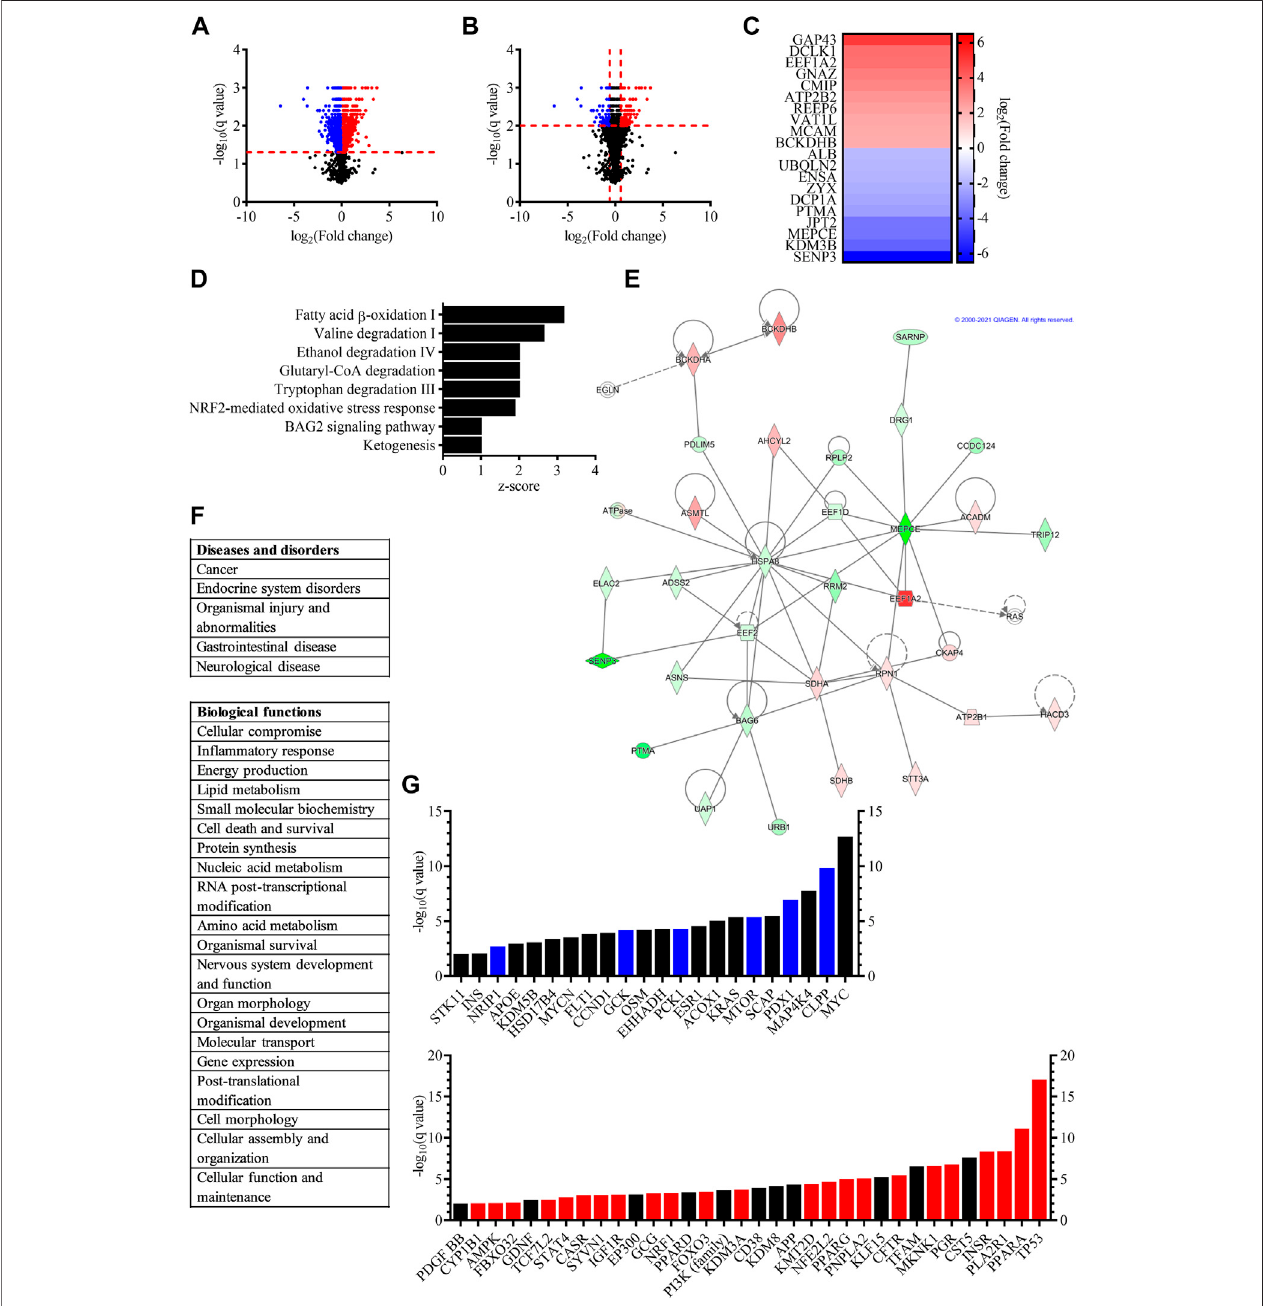
FIGURE 2 | Proteomic study revealed that proliferating and differentiated hVM1 clone 32 cells are in fl uenced by a wide variety of proteins and pathways. (A) Volcano plot, with fold change on the x -axis and the q value on the y -axis, showing differentially expressed proteins in dividing (blue dots) and differentiated (red dots) hNSCs with q < 0.05. Black dots indicate proteins that had a non-signi fi cant q value. (B) Volcano plot, with fold change on the x -axis and the q value on the y -axis, demonstrating differentially expressed proteins in proliferating (blue dots) and differentiated (red dots) hNSCs with q < 0.01. Black dots indicate proteins that had q > 0.01. (C) Heat map illustrating the proteins with the biggest fold change increased in dividing (blue) and differentiated (red) hVM1 clone 32 cells. (D) Bar graph showing the top canonical pathways of proliferating and differentiated hNSCs, with bars indicating the z-score of each pathway. (E) One of the top networks relevant to hVM1 clone 32 cells. Image from QIAGEN Ingenuity Pathway Analysis. (F) List of top diseases and disorders (top) , and list of top biological functions (bottom) of hVM1 clone 32 cells. (G) Bar graph illustrating the top upstream regulators of dividing (top) and differentiated (bottom) hNSCs, with bars indicating the q value. Blue and red bars indicate proteins that were activated in proliferating and differentiated cells, respectively. Black bars represent proteins that were top upstream regulators, but not activated. For panels (D – G) , the q value was set to 0.01. Proliferation n (cid:1) 5, Differentiation n (cid:1) 5. All data were obtained from at least three independent experiments.